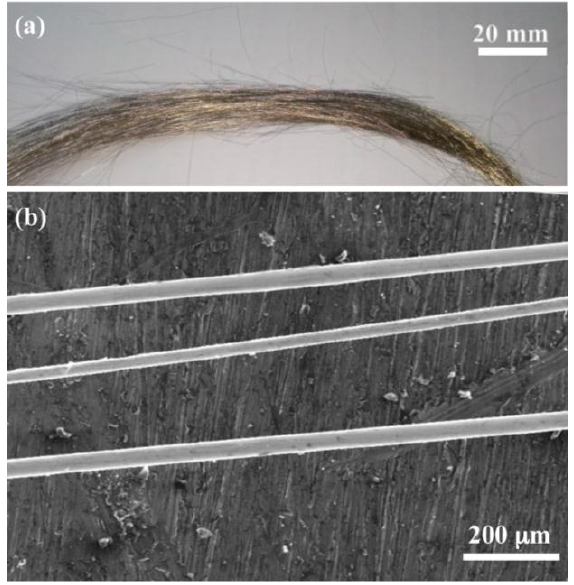
Figure 1. ( a ) Macro and ( b ) micro morphologies of melt-extracted Cu 48 Zr 48 Al 4 amorphous